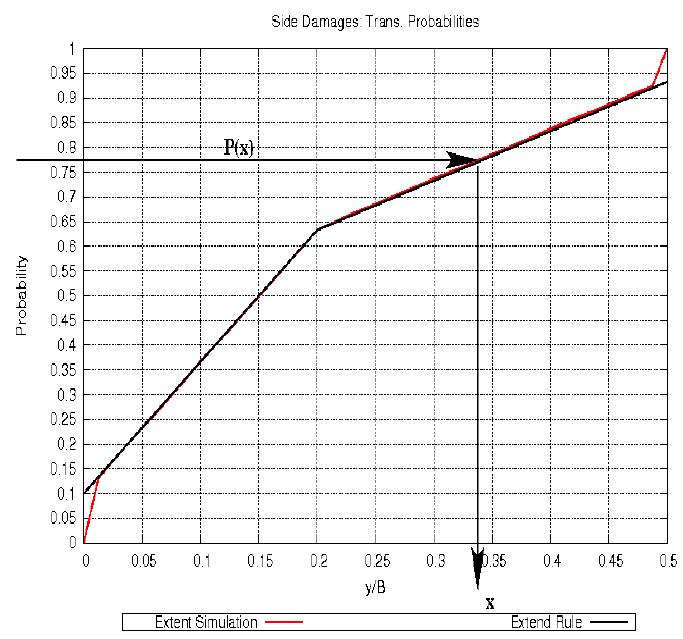
Figure 2. Principle of the Monte Carlo Method for damage stability problems. Here: Penetration depth for side damages.